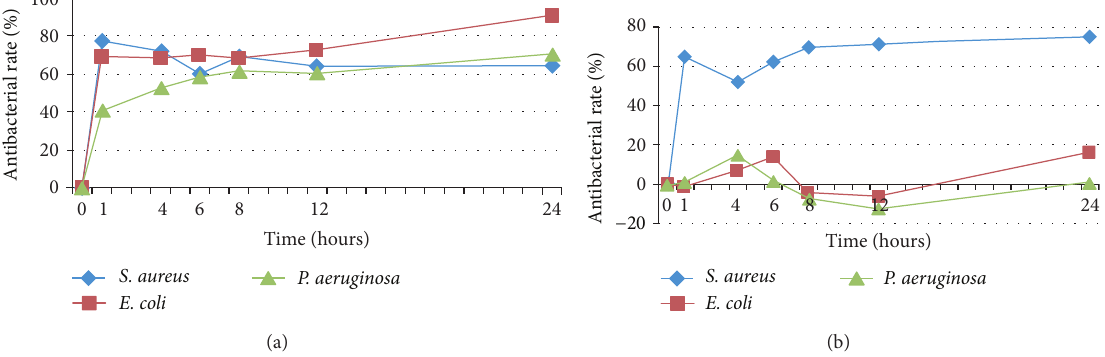
Figure 2: Antibacterial rate of APG against Staphylococcus aureus , Escherichia coli , and Pseudomonas aeruginosa ((a) compared to PBS group; (b) compared to PPP group). S. aureus : Staphylococcus aureus ; E. coli : Escherichia coli ; P. aeruginosa : Pseudomonas aeruginosa